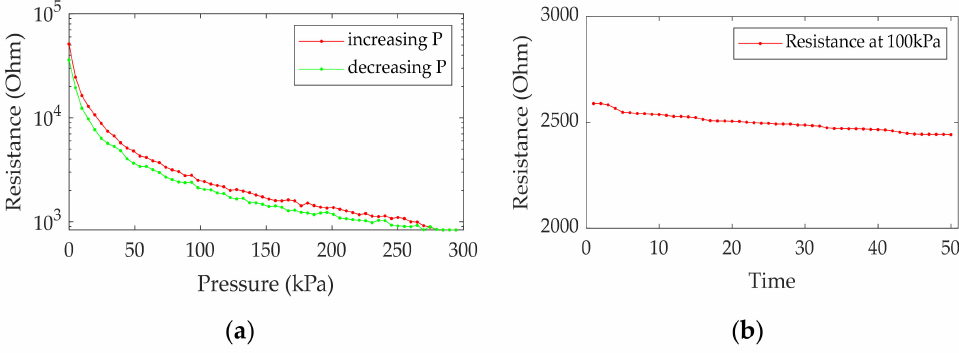
Figure 10. The sensor properties: ( a ) Sensor hysteresis; ( b ) Sensor